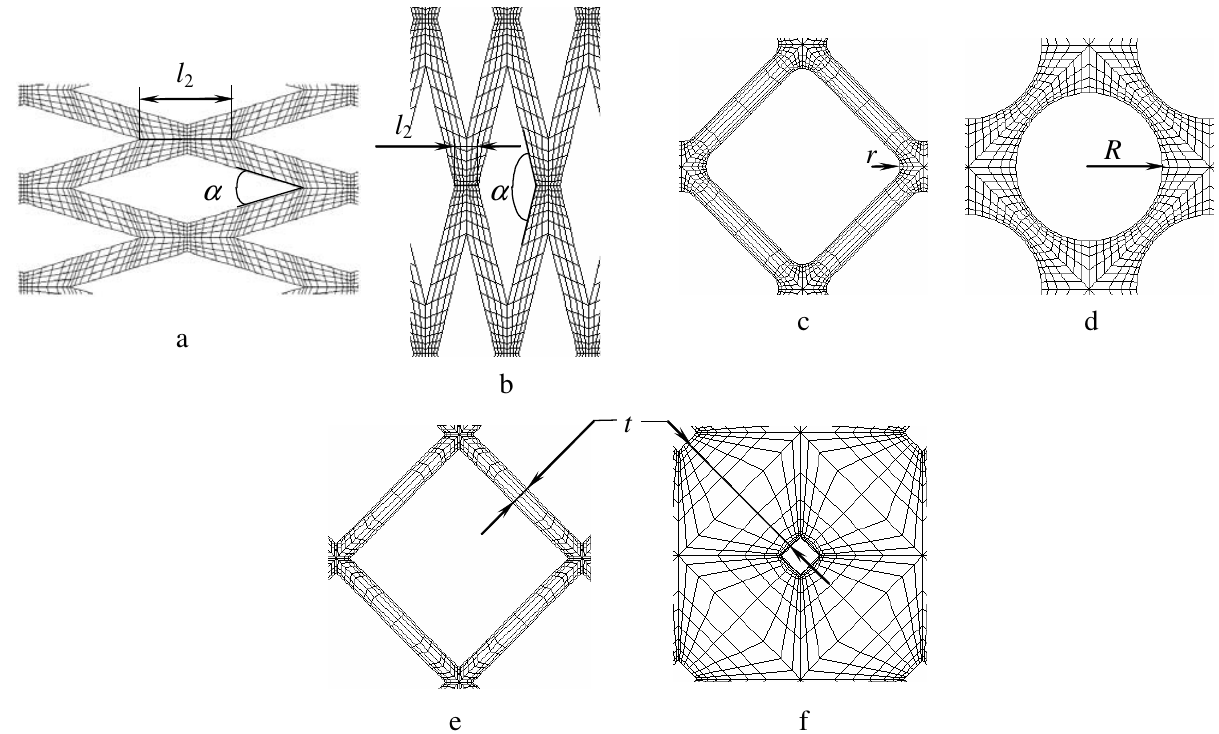
Fig 2. Numerical models: variable angle α between edges and variable length of vertex l 2 (a, b); variable rounding radius r of angle α (c, d); variable thickness of edge t (e, f)